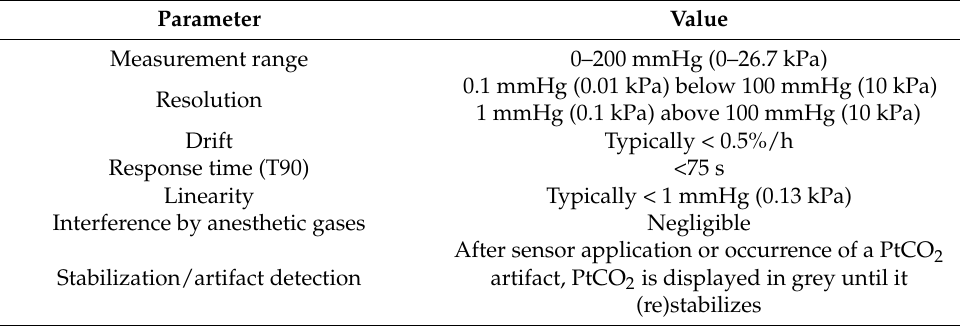
Table 1. Technical characteristics of the PtCO 2 sensor as reported in the user